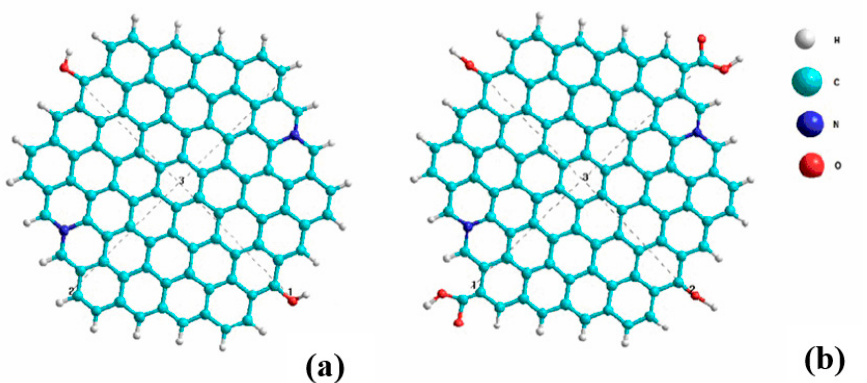
Figure 11. Graphene oxide layers models: ( a ) with OH group (GO2 model); ( b ) with COOH group (GO1 model).